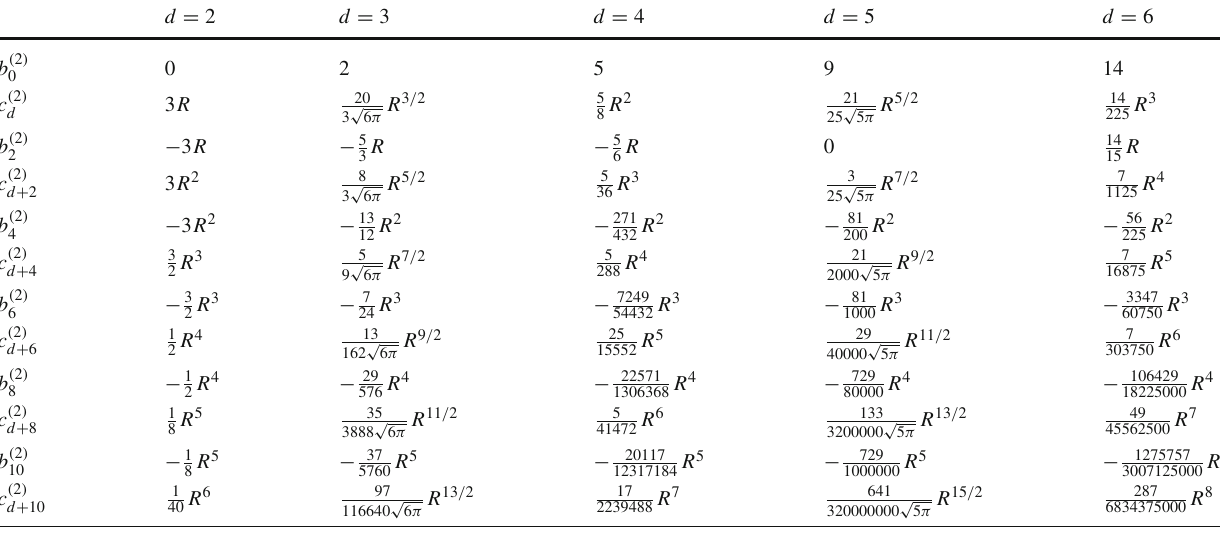
Table 3 The tensor heat kernel coefficients for different integer dimensions and vanishing endomorphism d =